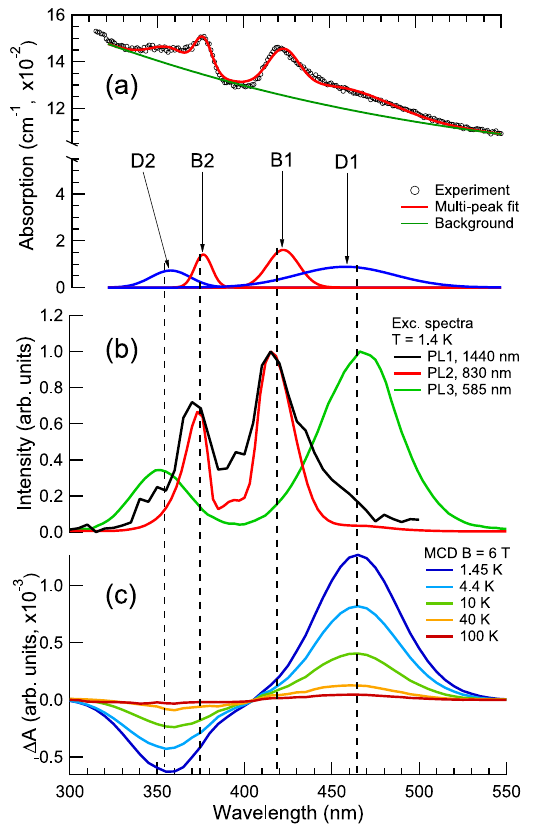
Figure 2. ( a ) Absorption spectrum recorded at room temperature. ( b ) Excitation spectra of PL1, PL2 and PL3 luminescence bands recorded at 1.4 K. ( c ) MCD spectra recorded at various temperatures in magnetic field B = 6